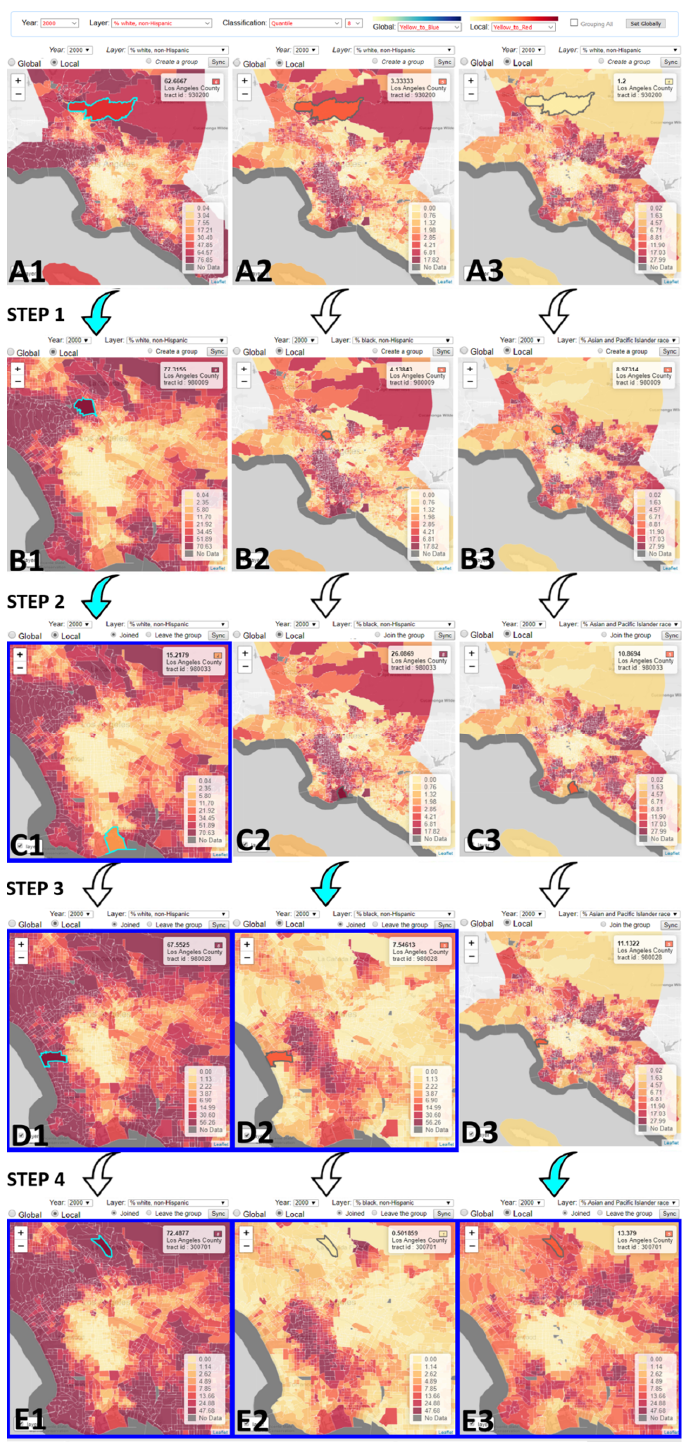
Figure 9. Continuous linking for a comparison of three variables: percentage of whites, blacks, and Asians and Pacific Islanders (from left to right). Step 1: The left map has been zoomed in on. Step 2: The “Create a group” button was clicked on the left map. Step 3: The “Join the group” button was clicked on the middle map. Step 4: The “Join the group” button was clicked on the right map. The animated version with narrations is available at http: // sarasen.asuscomm.com / acm /